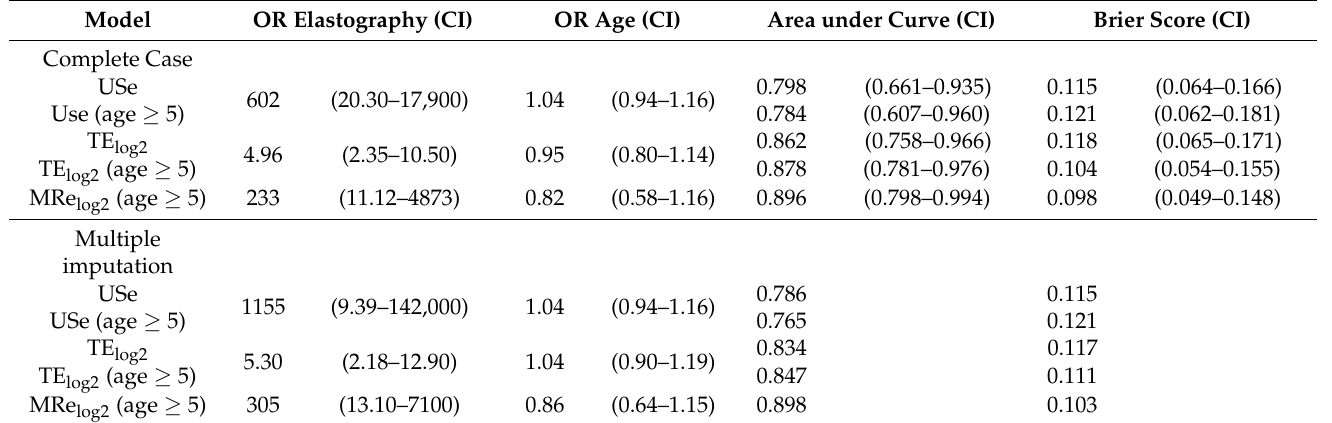
Table 2. Results from multivariate logistic regression models with advanced fibrosis (F3-4) as outcome and liver stiffness measures age and Alanine aminotransferase levels ≤ 470 as covariates.